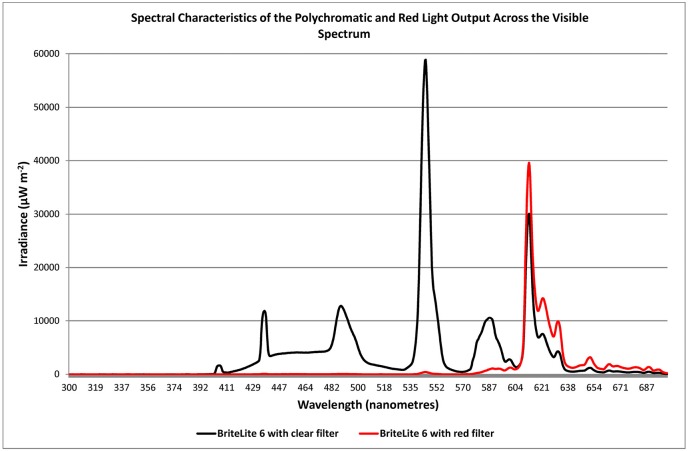
Irradiance spectra of the emission from the BL6 light source after filters were fitted resulting in modification of polychromatic emission with slightly translucent (full spectrum, < 15% intensity reduction; Lee Filters #420-Light Opal Frost, Y > 85%; black trace) or primary red emission filter (90.7% reduction in emission of all frequencies below the value of about 575 nm; Lee Filters #106-Primary Red, Y = 9.3%; red trace).